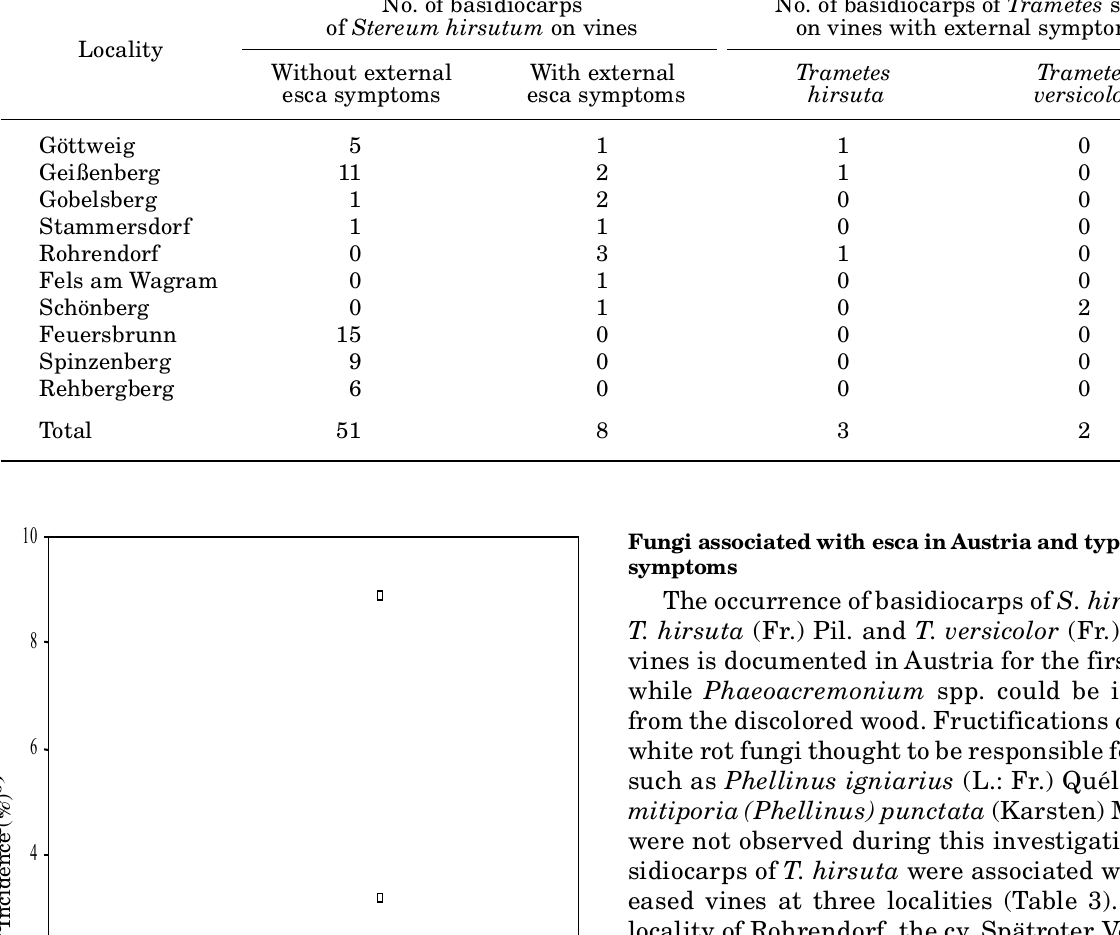
Table 3. Occurrence of basidiocarps of white-rot fungi on vines in Lower Austria. No. of basidiocarps